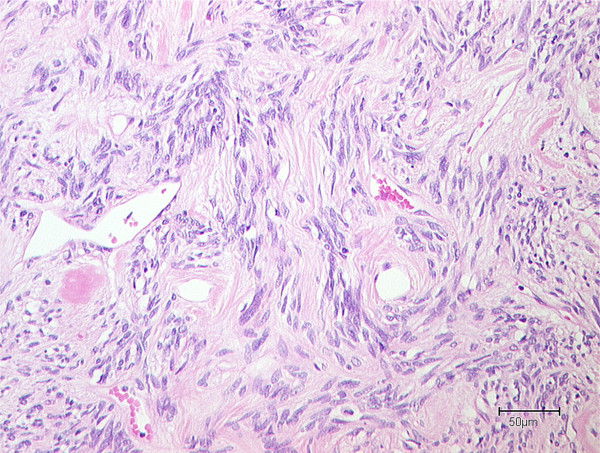
Microscopic aspect of SFT (b). Microscopic aspect of a solitary fibrous tumor, higher magnification: fibroblastic, partly "neural-like" tumor cells lying in a fibrous, partly hyalinized matrix, hemangiopericytoma-like blood vessels.